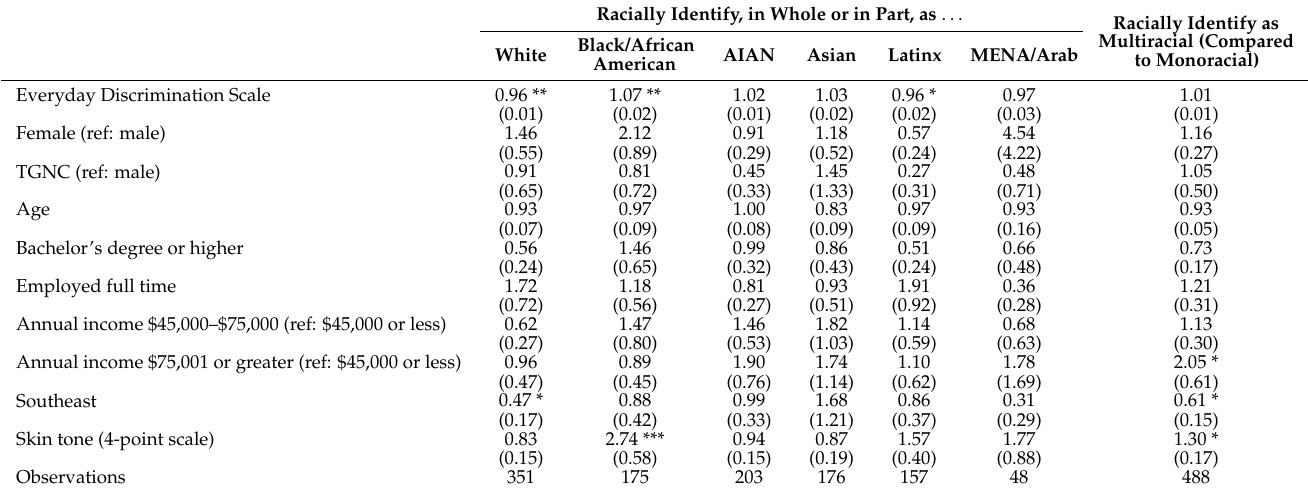
Multiracial (Compared to Monoracial)White